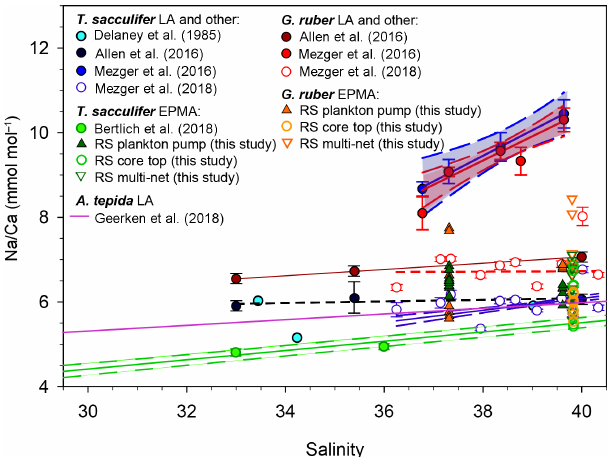
Figure 5. Comparison of most existing planktonic foraminifer Na / Ca-salinity studies, including different culture studies (Allen et al., 2016; Bertlich et al., 2018; Wit et al., 2013; Delaney et al., 1985), a field survey (Mezger et al., 2016, 2018) and a benthic cul- ture study (Geerken et al., 2018) compared to new electron micro- probe shell Na / Ca values of Red Sea plankton pumps, core tops and multi-nets (this study). Distinction had been made between EPMA and laser ablation (LA) measurements, where EPMA measurements refer to shell-only measurements. The shown regressions are asso- ciated with the data points in the same